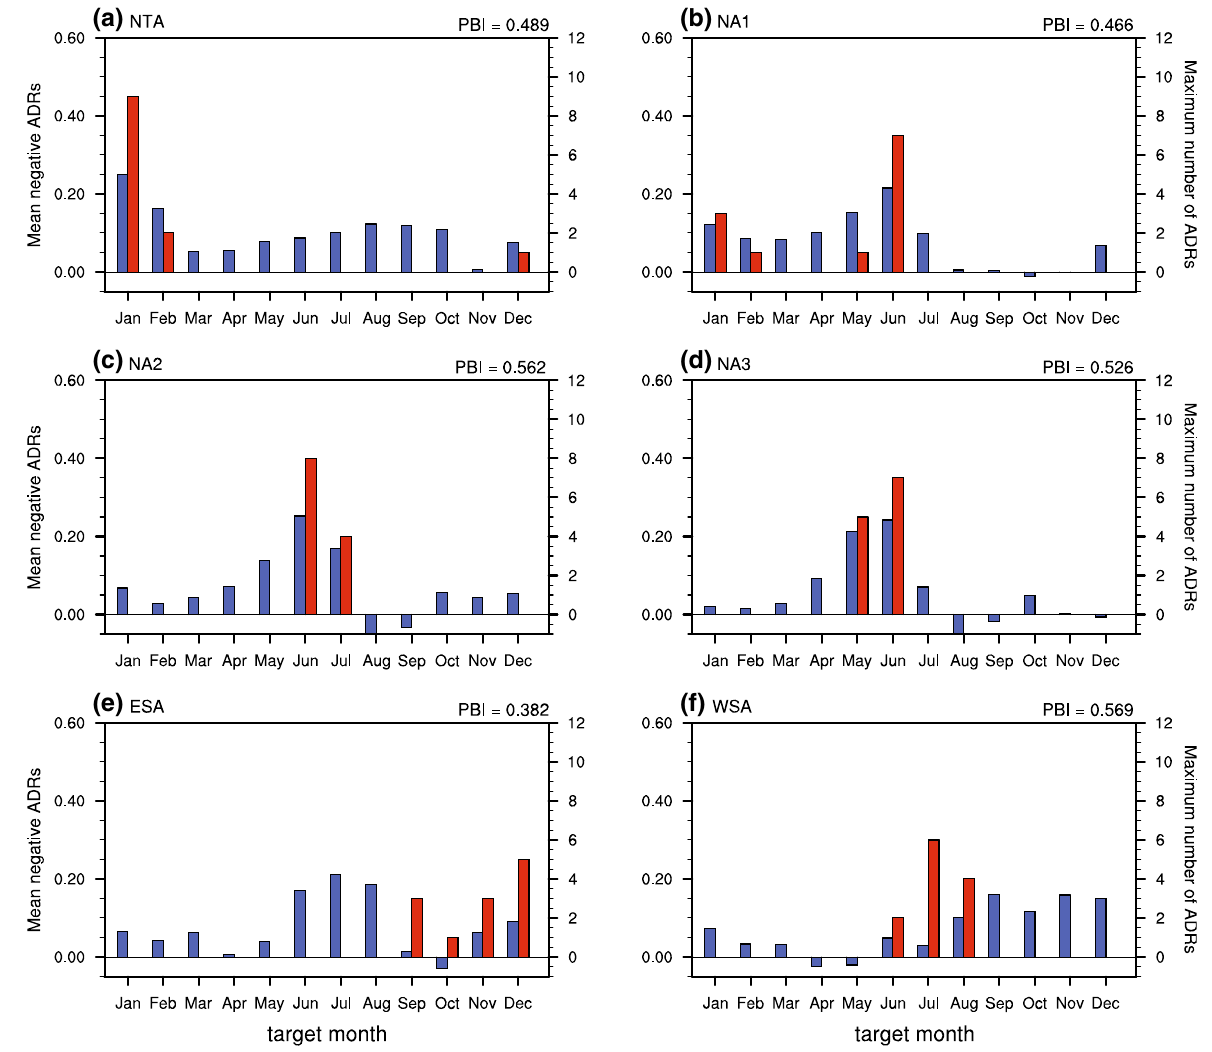
Fig. 5 Mean ADRs for all 12 lead months (left y axis) and the frequency of the maximum ADRs (right y axis) as a function of the target calendar month (x axis) for the a northern tropical Atlantic (NTA), b the south lobe of the three regions in the North Atlantic (NA1), c the middle lobe of the three regions in the North Atlantic (NA2), d the north lobe of the three regions in the North Atlantic (NA3), e eastern South Atlantic (ESA), and f western South Atlantic (WSA). Blue bar is the mean ADRs for all 12 lead months (left y axis), and red bar is the frequency of the maximum ADRs (right y